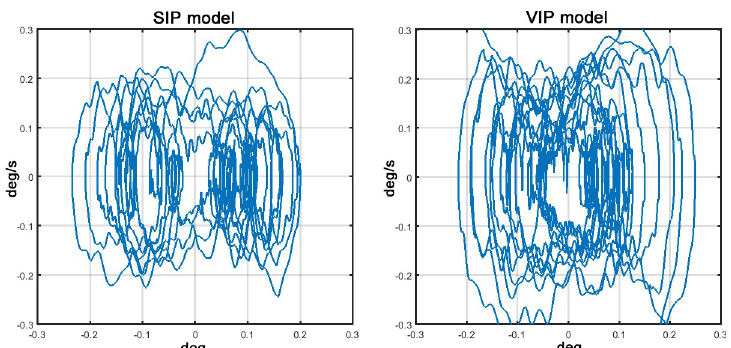
Fig 5. Sway orbits in the phase plane ( q . _ q ). Left Panel: oscillations of the SIP model. Right panel: oscillations com vs com of the VIP part of the hybrid DIP/VIP model. Both orbits correspond to a 60 s sway. In order to better understand such similarity of VIP-SIP oscillations, we may consider the range of variation (RoV) of different variables during an observation window of 180 s, having defined as “range” the interval containing 90% of the samples stored during the observation time. Table 4 shows the RoVs for angular rotations, angular speeds and angular accelerations of the two models (DIP/VIP vs. SIP).